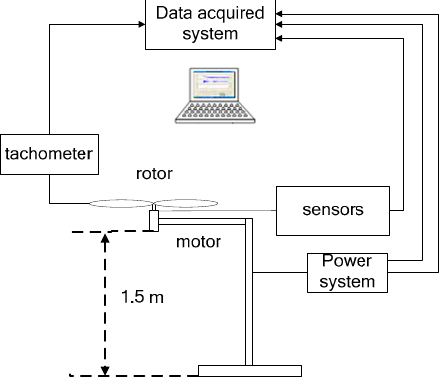
Figure 3. Schematic diagram of experimental setup. Table 2. Specific parameters of the experiment.